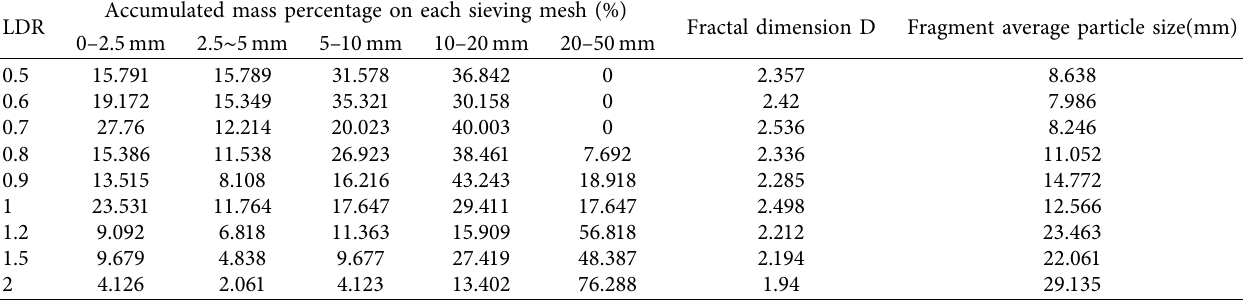
Table 2: The results of sieving test of granite specimens fragments.